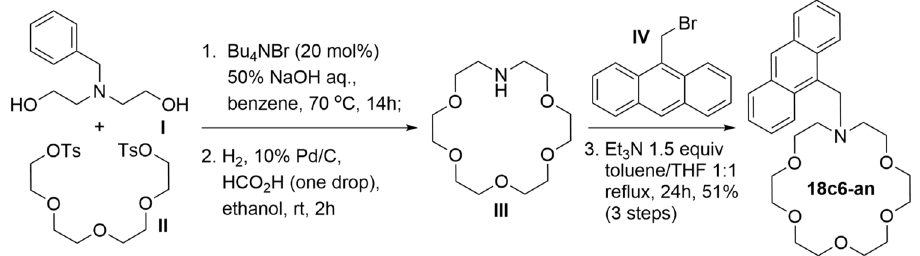
Figure 10. Example synthesis of 18c6-an. For more information see supplementary information.